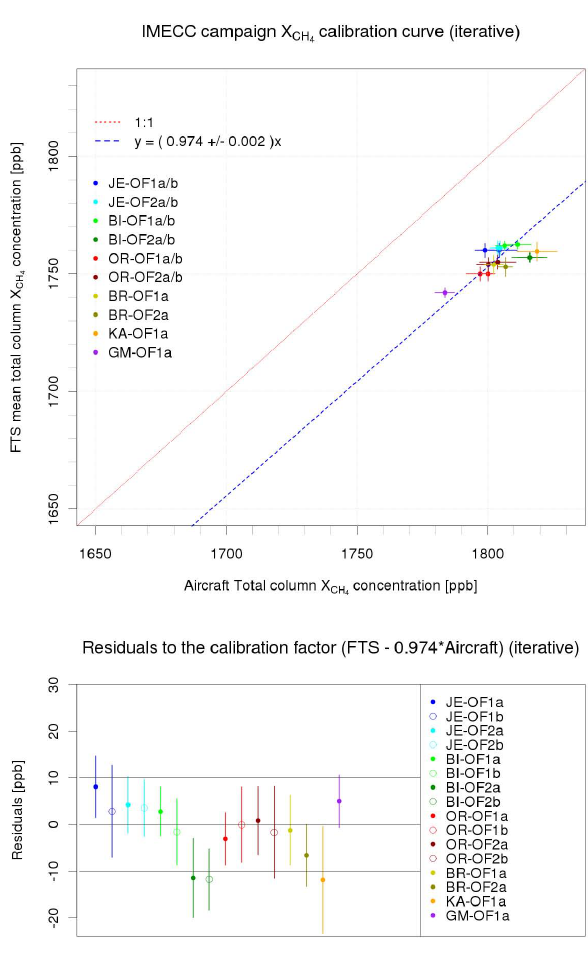
Fig. 12. Upper part: calibration factor derived by an iterative cal- culation for the IMECC campaign data. Lower part: corresponding